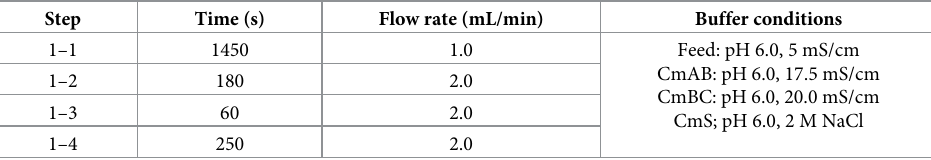
Table 1. Optimised SMB CEX operation parameters applied on three 1.33 mL